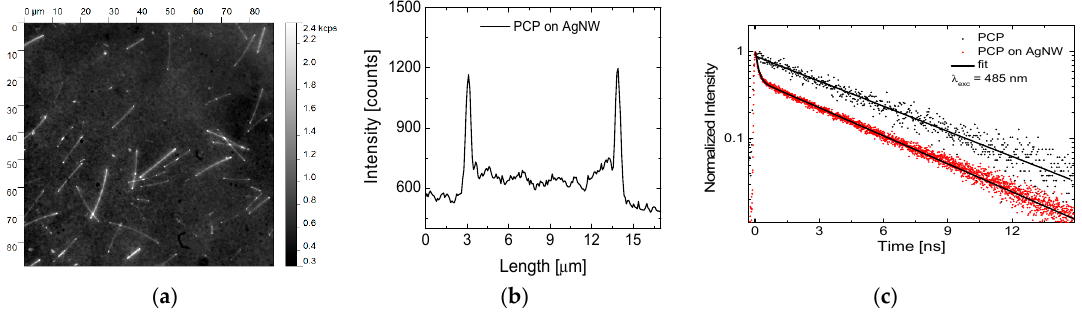
Figure 3. Results of fluorescence imaging and spectroscopy of peridinin-chlorophyll-protein (PCP) complexes mixed with silver nanowires: ( a ) fluorescence map excited at 405 nm, ( b ) intensity cross-section along an exemplary nanowire, and ( c ) comparison of fluorescence decay curves for the excitation spot placed on a nanowire (red) and off the nanowire (black); Lines correspond to fits.